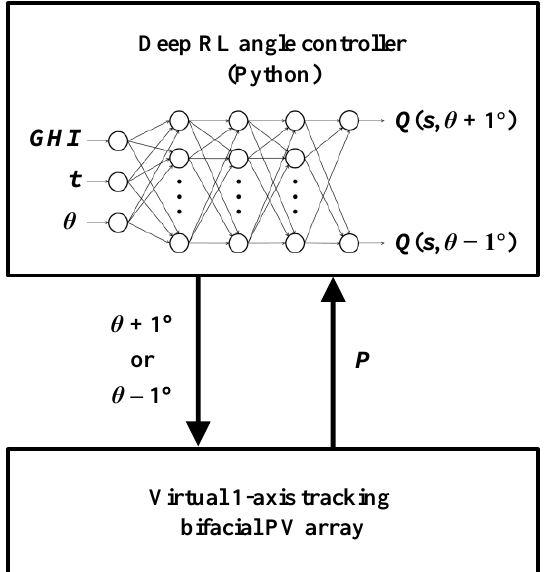
Figure 3. Data exchange between deep RL angle controller and virtual 1-axis tracking BPV array.